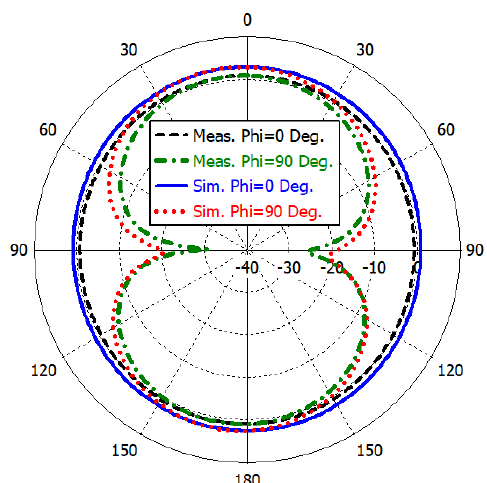
Figure 11. The far-field radiation patterns for the proposed filter-antenna design.